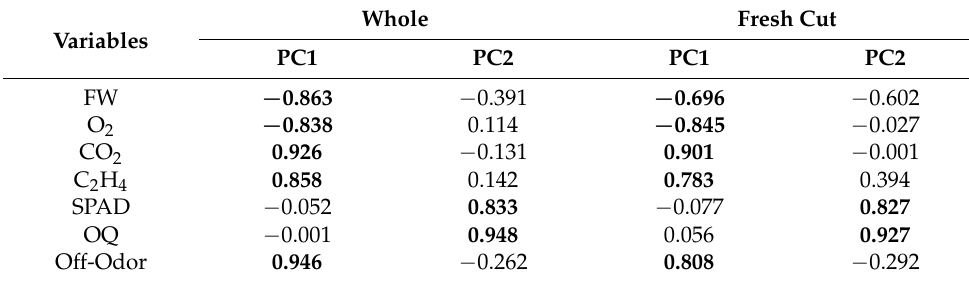
Table 5. Correlation of variables to the factors of PCA based on factor loadings.